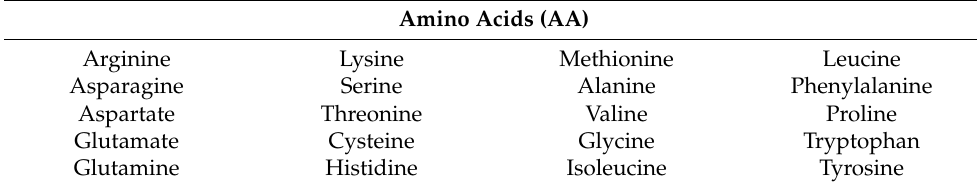
Table 1. Amino acids used as input data to our algorithm.